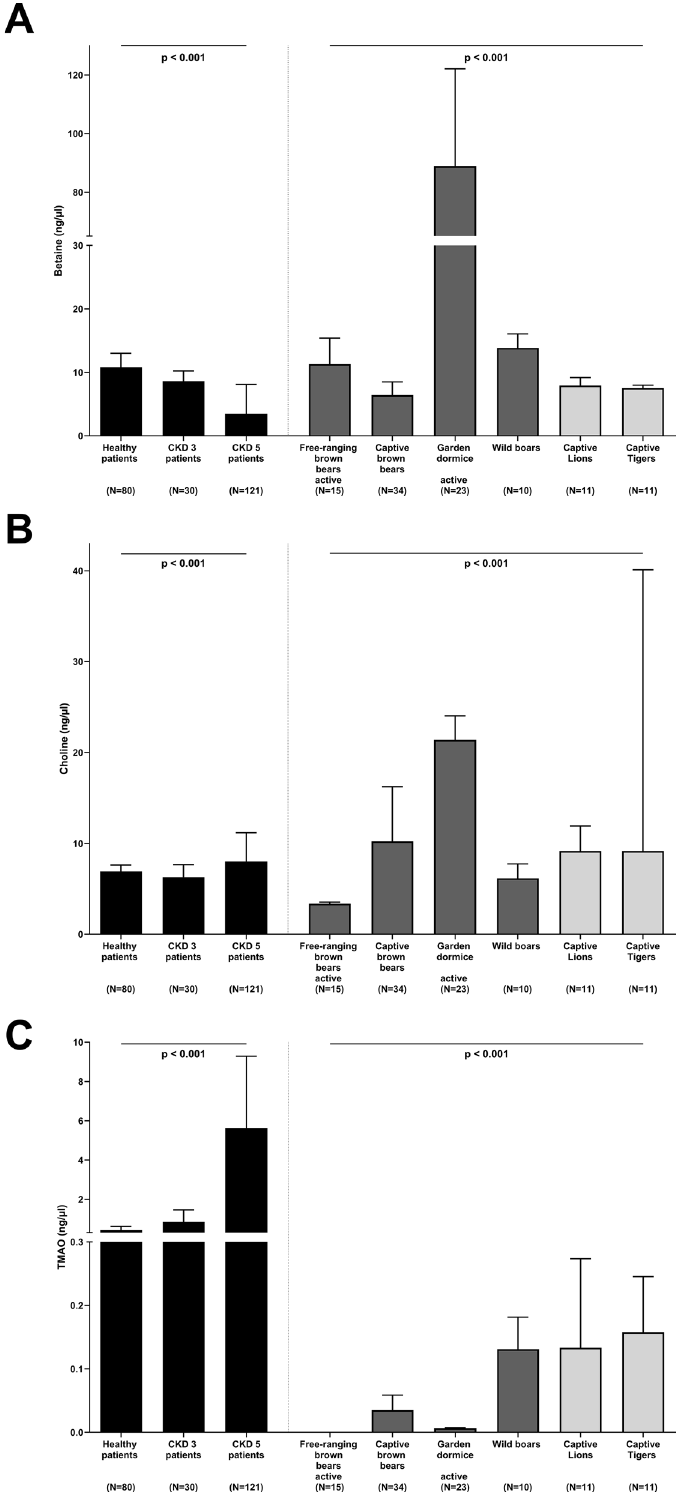
Figure 2. Circulating levels of ( A ) betaine, ( B ) choline, and ( C ) trimethylamine N-oxide (TMAO) in human subjects (black bars) with normal renal function compared to patients with chronic kidney disease (CKD) stage 3 and 5, as well as different animal species, i.e. free-ranging, active brown bears; captive brown bears; captive, active garden dormice; wild boars; captive lions; and captive tigers. Animals are color-coded depending on their diet, i.e. omnivores (dark grey bars), and carnivores (light grey bars). Results are shown as median (interquartile range). Overall p values between the three groups of human subjects, as well as between animal species, were assessed by non-parametric Kruskal–Wallis test. Group-wise comparisons using Bonferroni post hoc analysis are described in the Results section. Number of participants or animals included in each group is